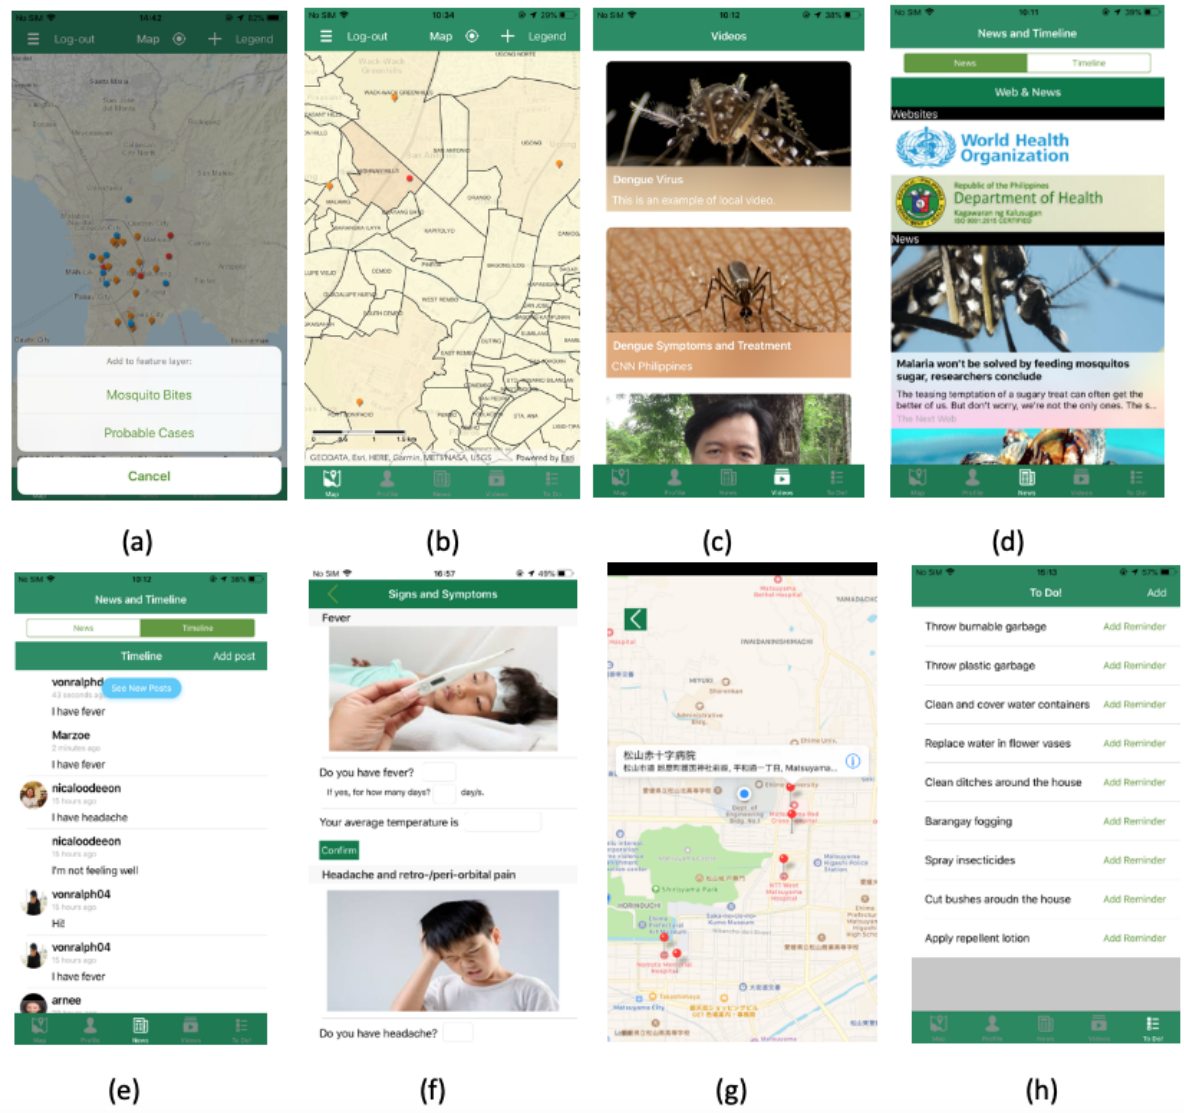
Figure 2. Screenshots of the Mozzify app. (a) Real-time dengue fever cases and mosquito bite reporting and mapping, (b) dengue fever hotspots, (c) within-app educational videos, (d) worldwide news and health agencies websites, (e) chat forum (timeline), (f) symptoms checker, (g) hospital directions, and (h) reminders alert